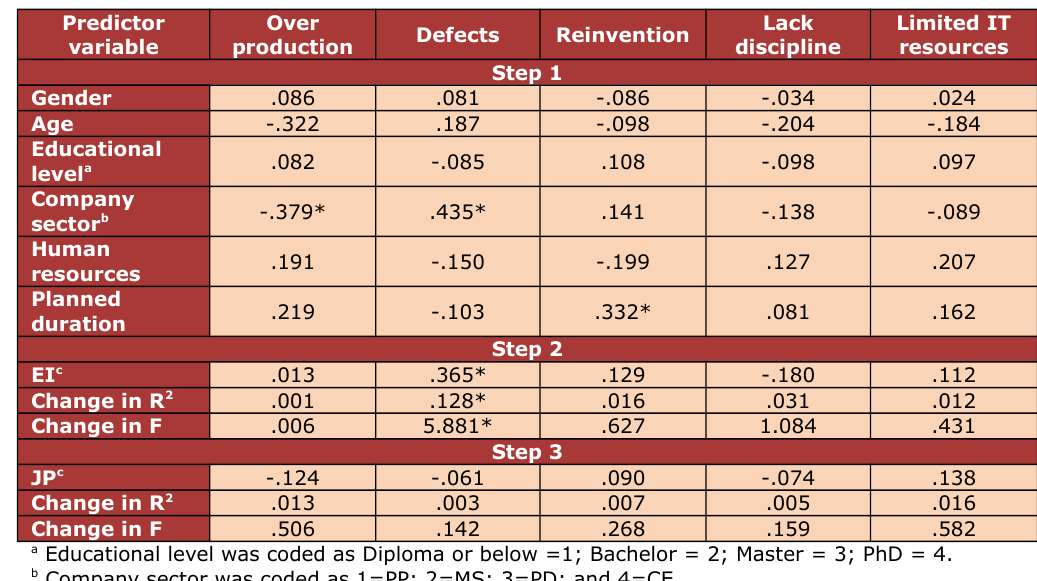
Table 7. Effect of EI and JP on VSM performance indexes